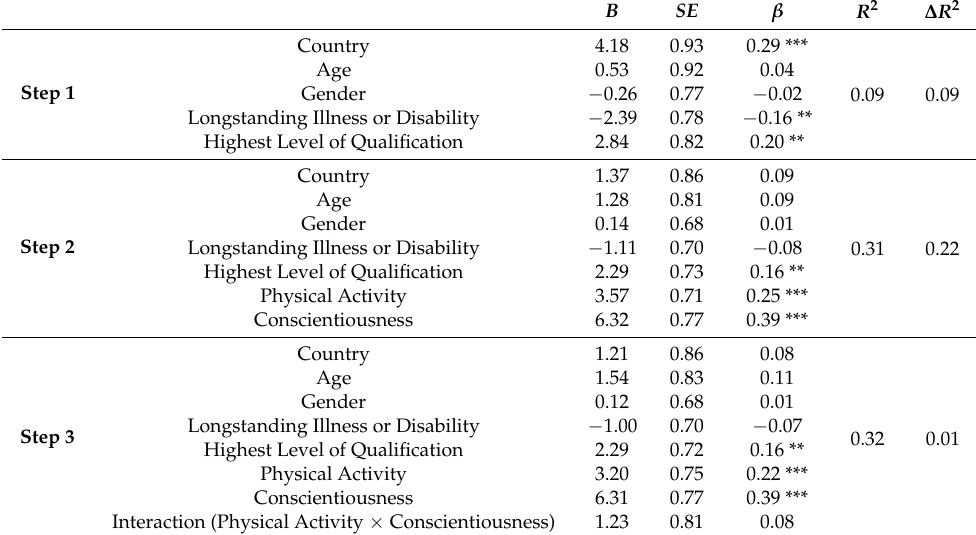
Table 6. Interaction analysis for physical activity and